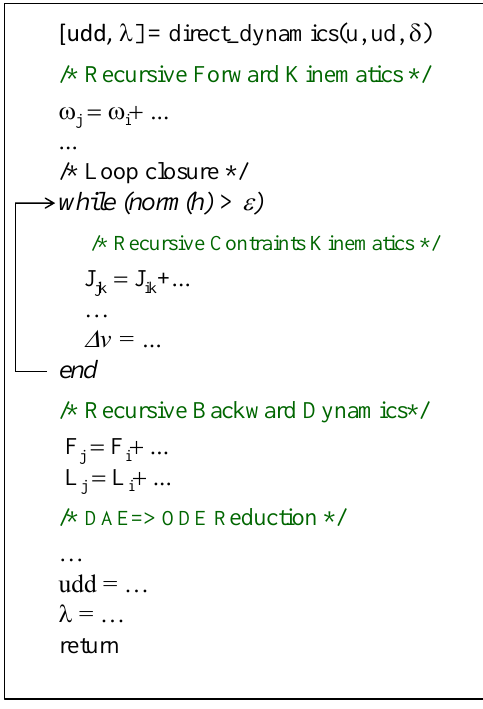
Figure 10. Recursive symbolic computation of the constraints: lo- cal iterative